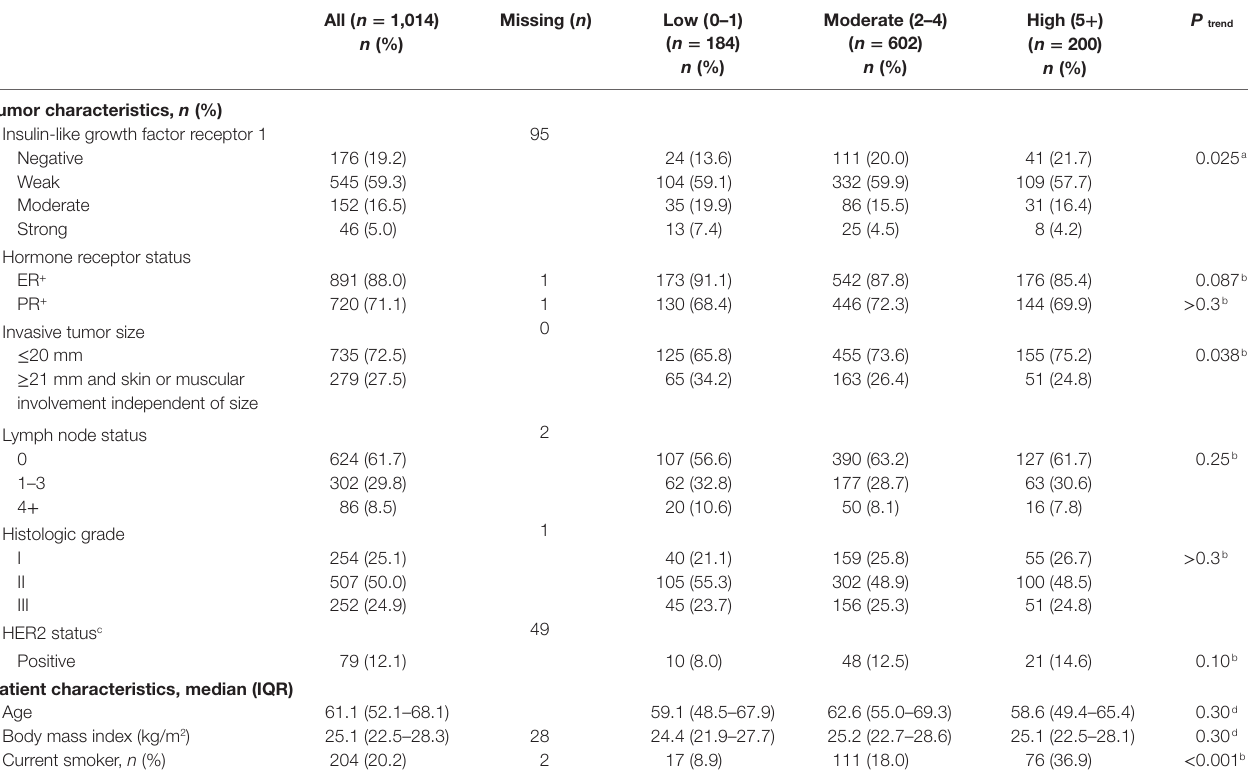
TaBle 1 | Tumor and patient characteristics of 1.014 patients in relation to daily coffee consumption